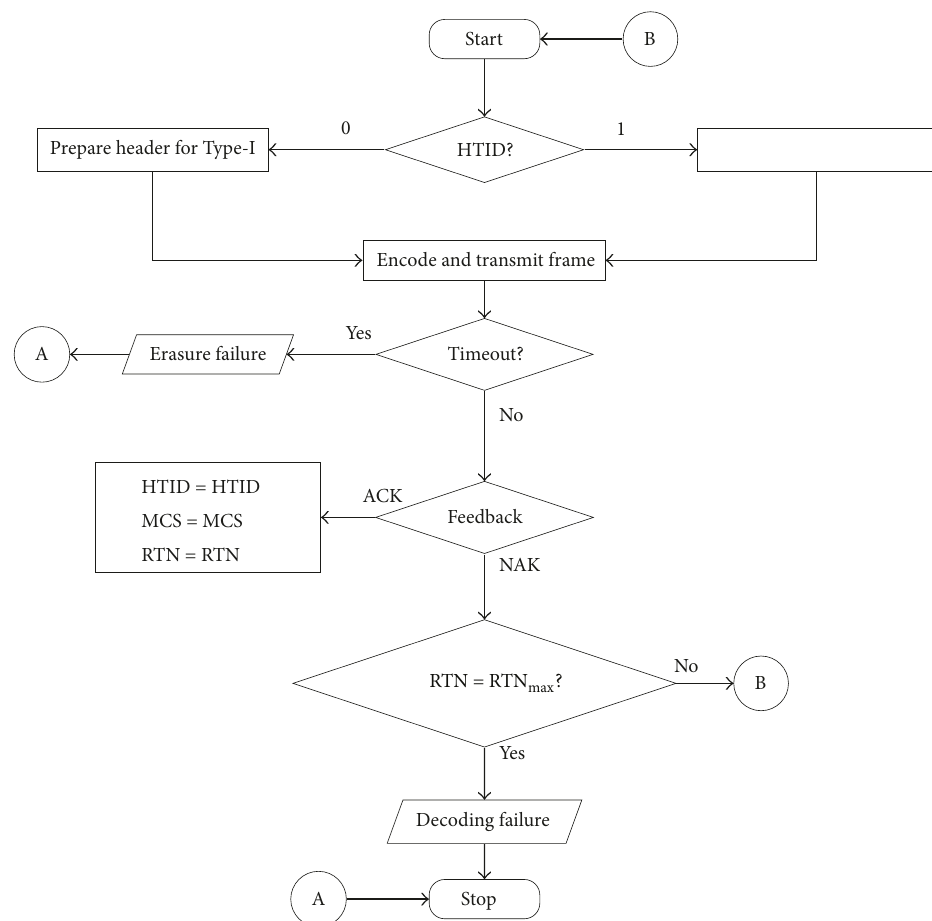
Figure19:Flowchartshowingthe master modeofoperationfortheHARQcontrolalgorithm.HTID:HARQtypeidentifier,MCS:Modulation and Coding Scheme, RTN: ReTransmission Number, and CRC: Cyclic Redundancy